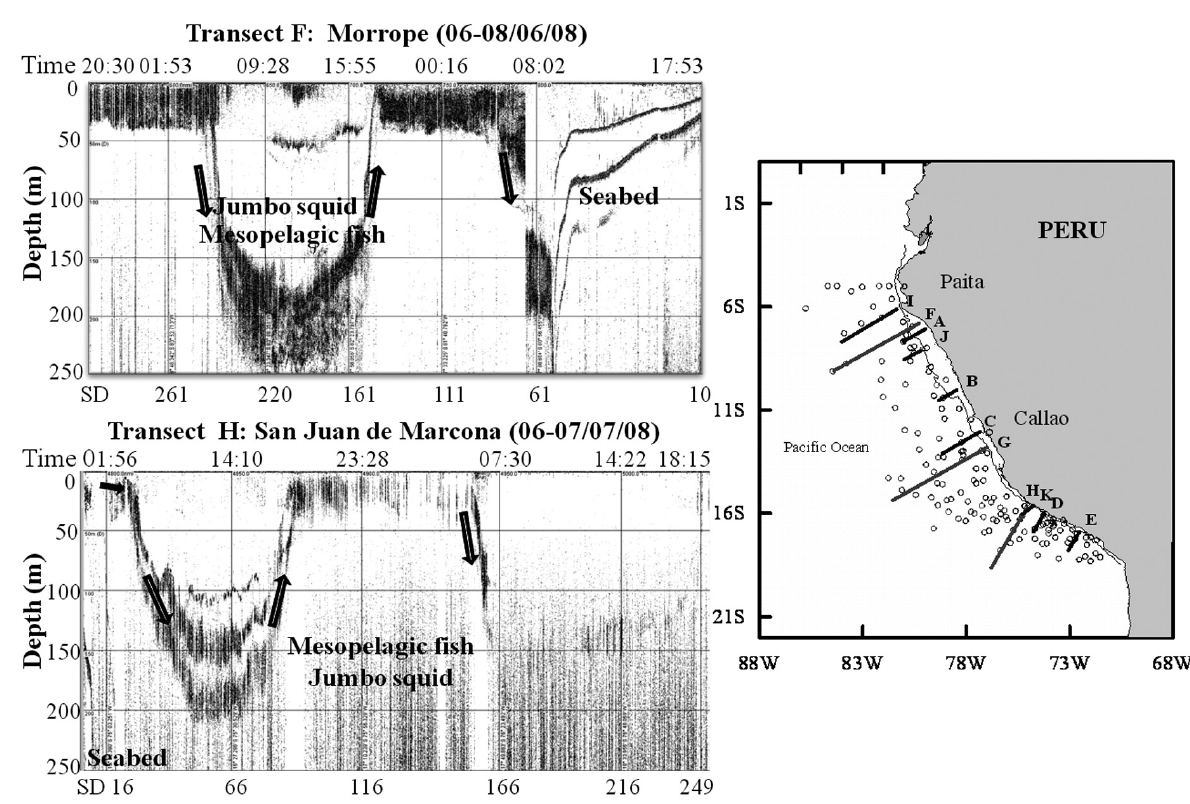
Fig . 3. – Acoustic detection of V. lucetia and D. gigas in 2007 and 2008 in the Humboldt Current System off Peru. Transect A, B, C, D and E were completed in March 2007; F, G and H in June-July 2008; and I, J and K in November-December 2008. SD, seashore distance in nautical miles. Vertical movements of jumbo squid and V. lucetia were clearly detected in the echogram of transects F and